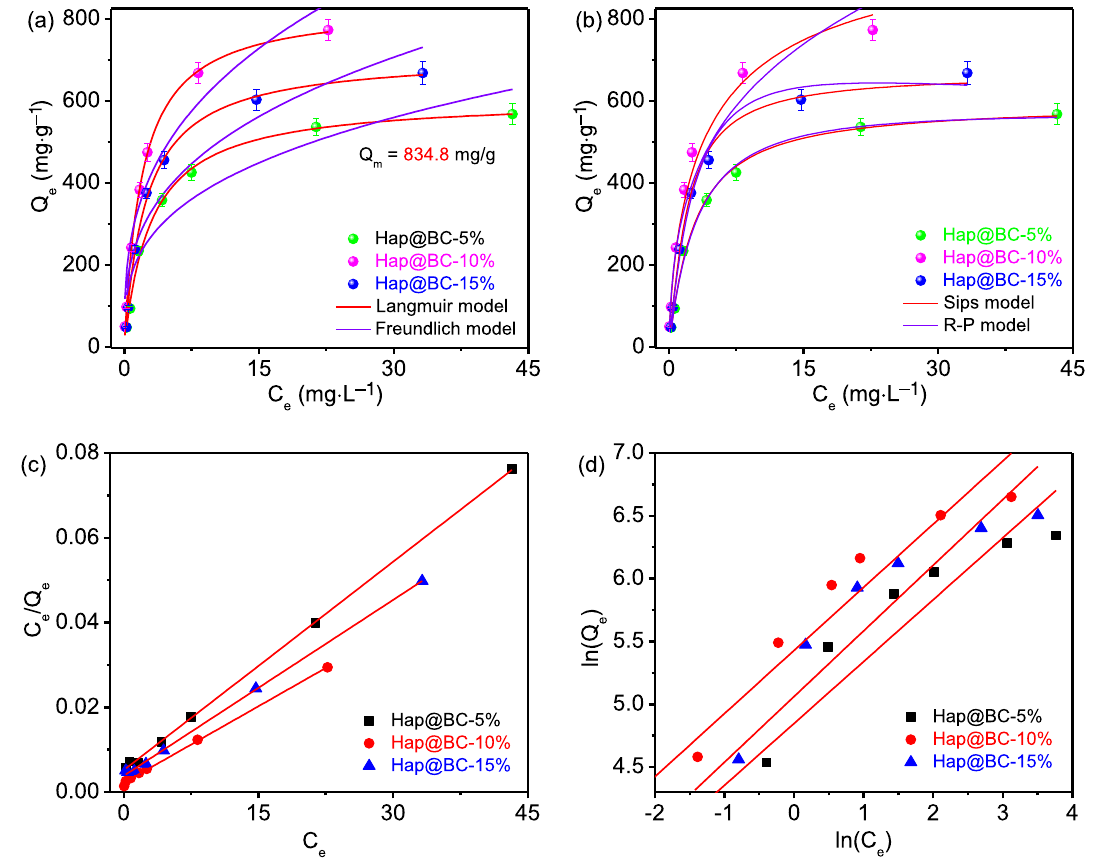
Fig. 6 Adsorption isotherm models: a Nonlinear Langmuir and Freundlich models, b Sips and R–P models, c Linear Langmuir model and d Linear Freundlich model (pH = 3, m/V = 0.1 g/L and T = 298